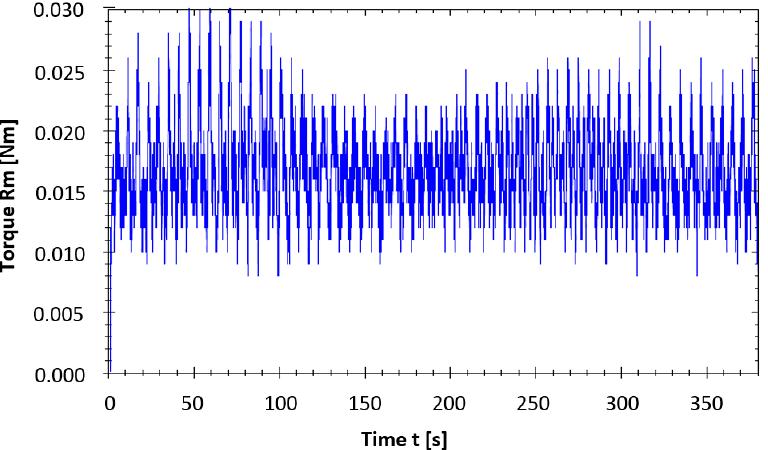
Figure 9. Starting torque (Rm) BR TS 050-63, s/n.1901—CW direction (before the trial run).